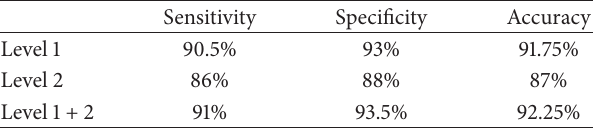
Table 2: Results obtained using the proposed feature in G channel.